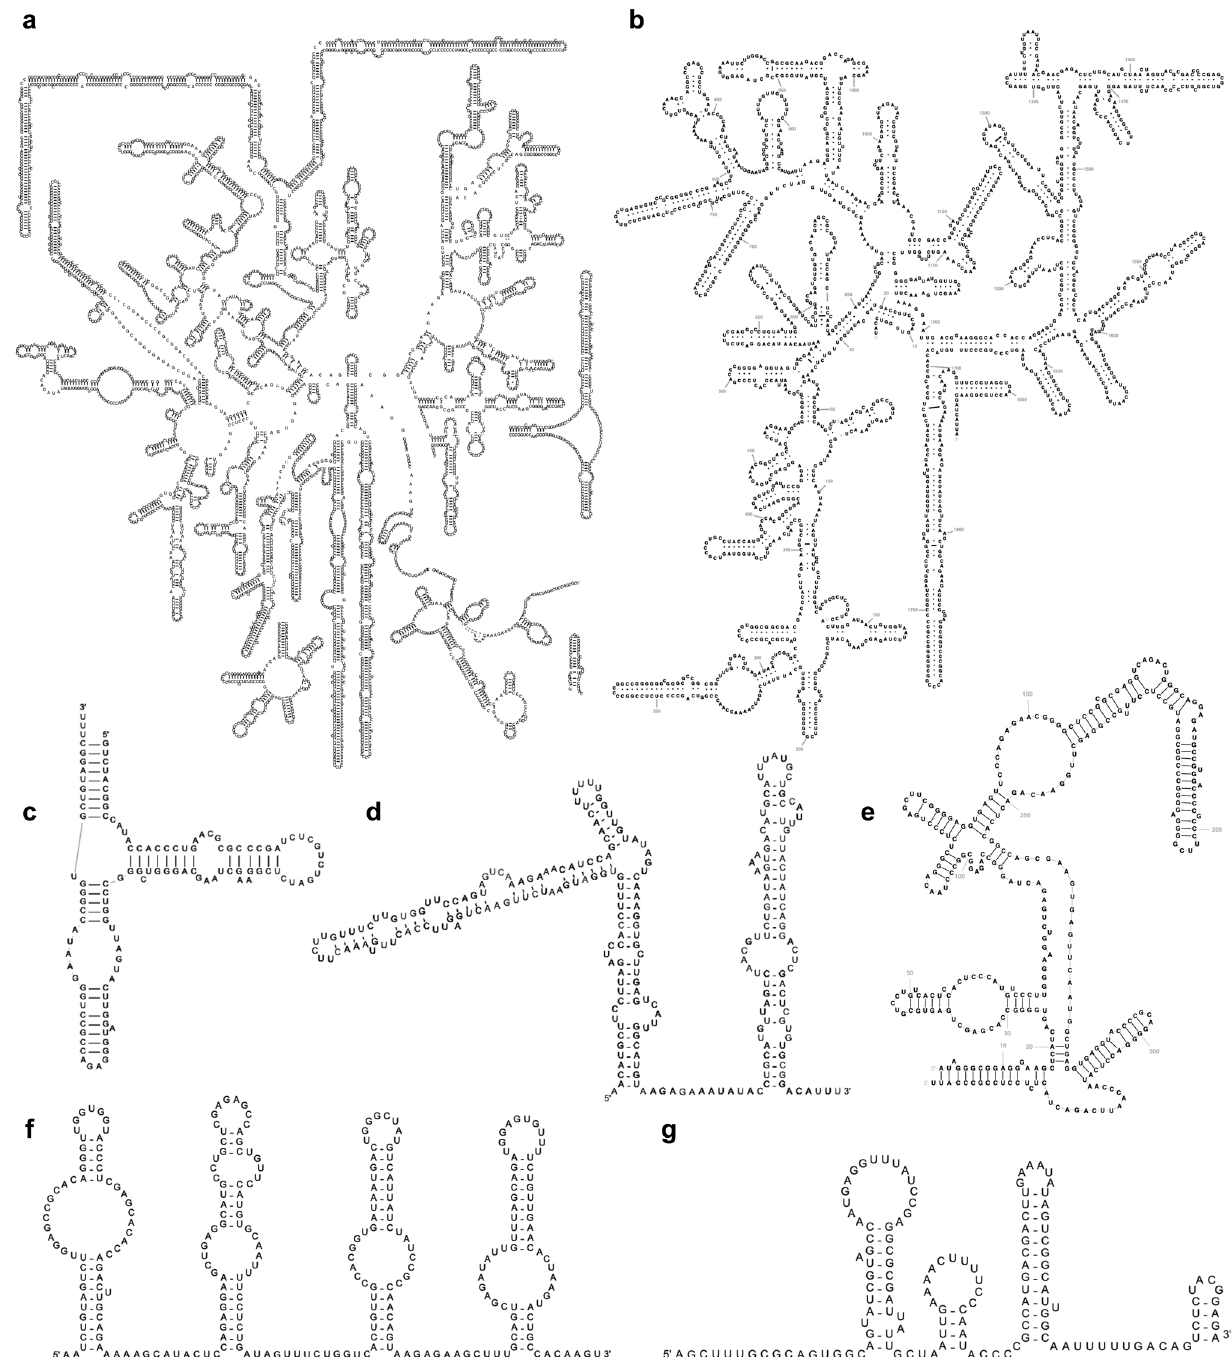
Fig. 2 Example human RNA 2D structures generated by R2DT. a Cytoplasmic LSU rRNA (RNAcentral accession URS0000ABD82A_9606); b cytoplasmic SSU rRNA (URS0000726FAB_9606); c 5S rRNA (URS00000F9D45_9606); d SNORA53 RNA (URS000075B5A7_9606); e RNAse P (URS000013F331_9606); f SCARNA13 RNA (URS000026BDF0_9606); g U4 snRNA